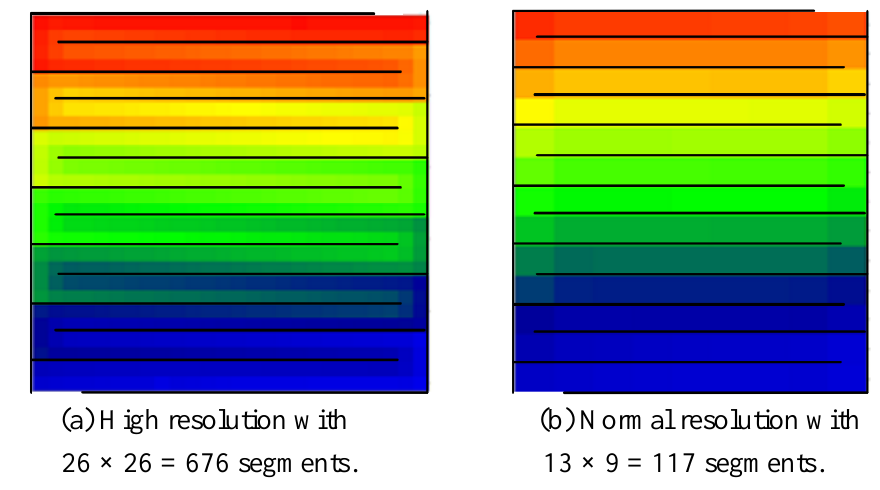
(b) Normal resolution with 13 × 9 = 117